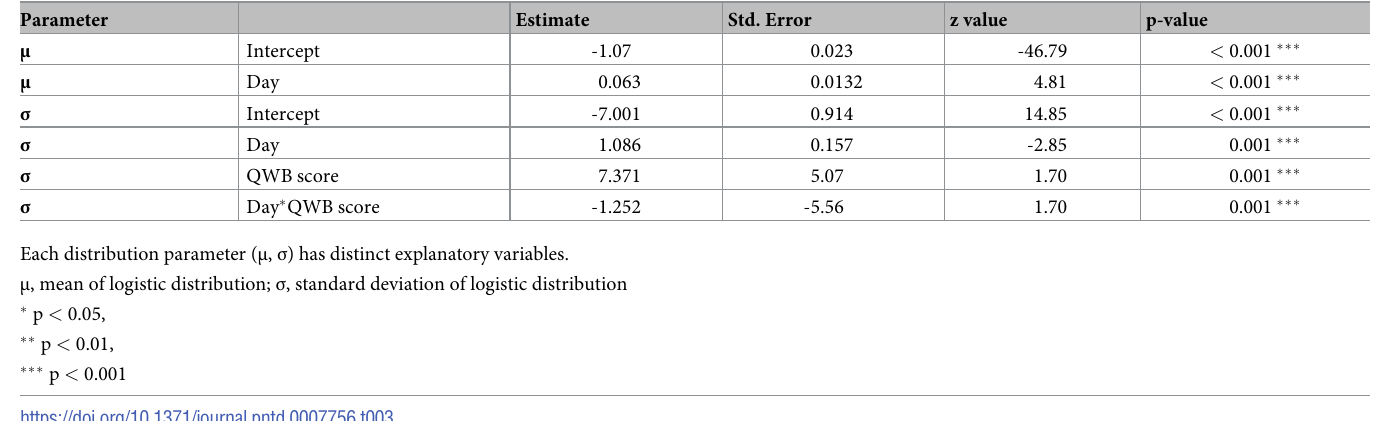
(2) refine estimates of the effects of mild symptomatic dengue illness on movement by quanti- fying changes before, during and after the symptomatic phase of infection; and (3) suggest the need to better account for disease-driven mobility behavior changes in DENV transmission models [31, 53].